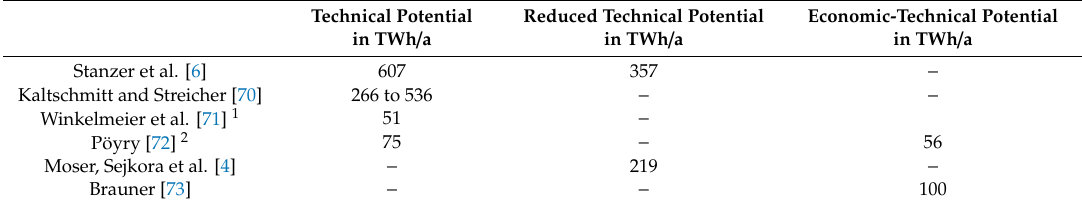
Table 4. Austrian RES potential